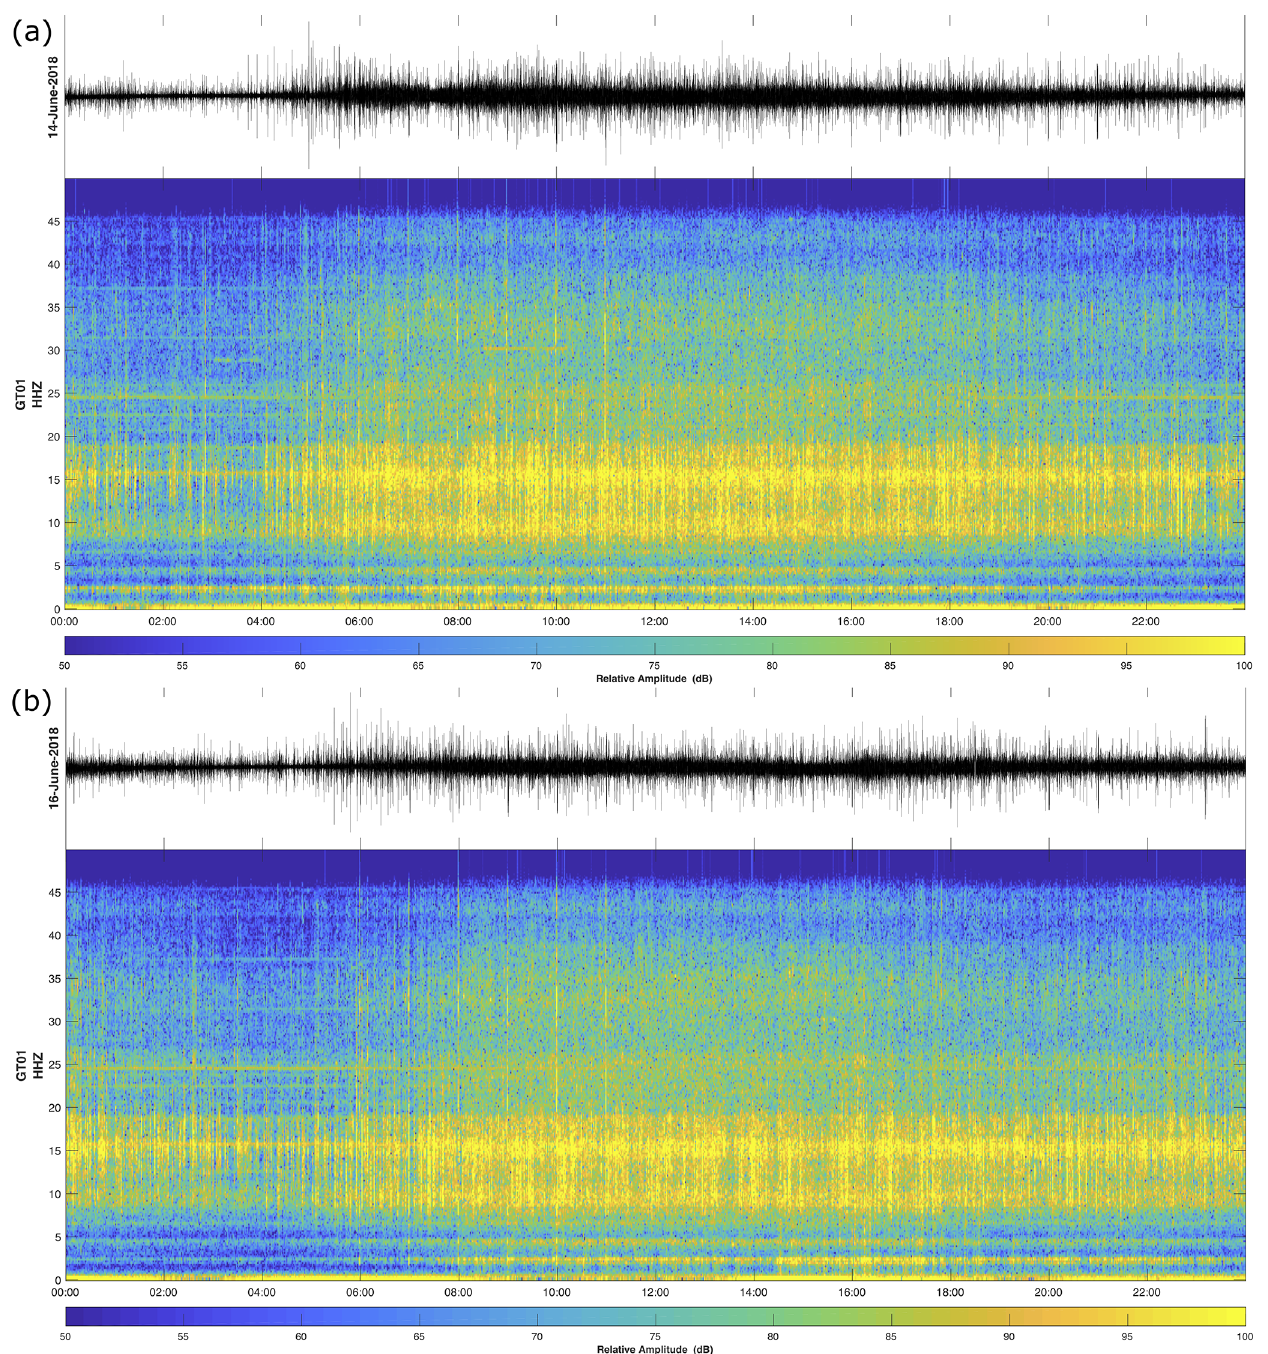
Figure 6. Spectrograms of the time-domain data shown in Fig. 5. The spectrogram is displayed in the bottom portion of panels: (a) a weekday and (b) a day on the weekend. The top portion of each panel condenses the 24h of waveform data shown as a helicorder record in Fig. 5 into a single trace. The spectrograms show that there is strong energy in the 10–20Hz frequency band throughout the day; this energy is almost continuous on the weekends (b) but wanes slightly overnight on a weekday (a)